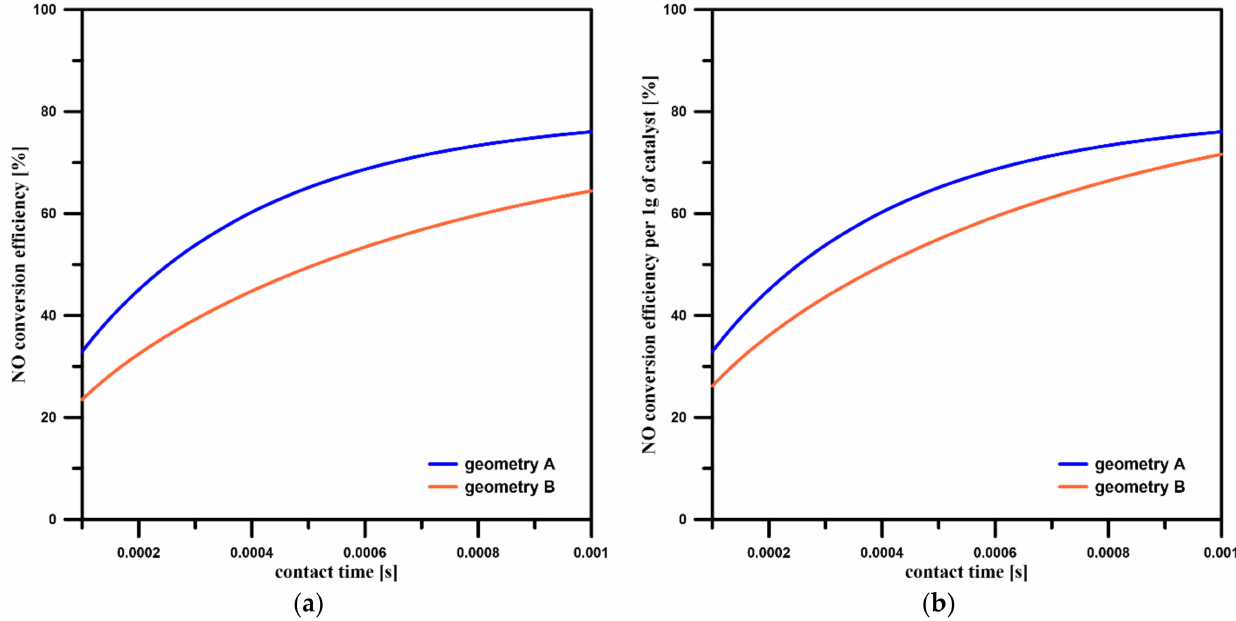
Figure 7. Conversion efficiency ( a ) and conversion efficiency per catalyst mass ( b ) as a function of contact time for Geometries A and